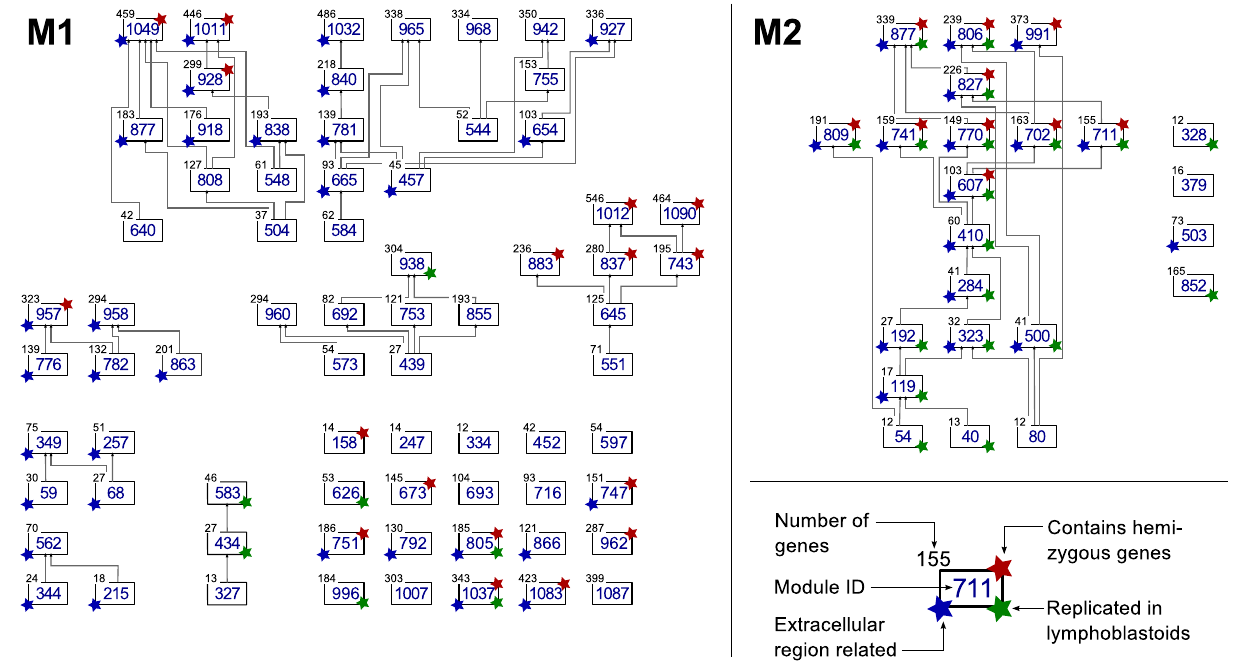
Figure 3. Hierarchical diagram of the transcription modules dysregulated in WBS identified in the M1 (left) and M2 (right) modular studies. Directed edges indicate direct subset relationships, and they always point upwards. The number of genes in a module is shown at the top left corner of the module box. Modules annotated with a red star on their top right corner contain at least one hemizygous (or flanking) gene; the ones with green stars on their bottom right corner were replicated in lymphoblastoid cell lines; blue stars on the bottom left corner indicate modules that show significant enrichment for extracellular region genes. An interactive version of this figure is available in the online supporting material at http://www.unil.ch/cbg/ISA/Fibroblasts, which allows to further query the gene content and functional enrichment of the modules.